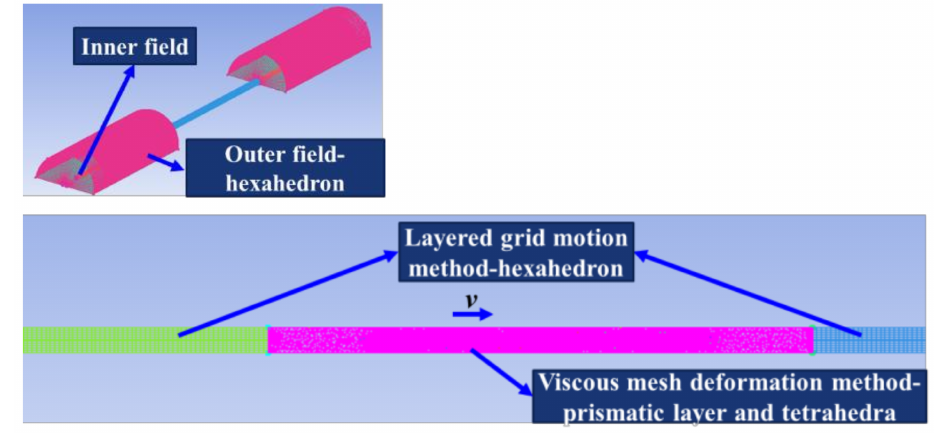
Figure 9. Hybrid meshing and grid motion method.